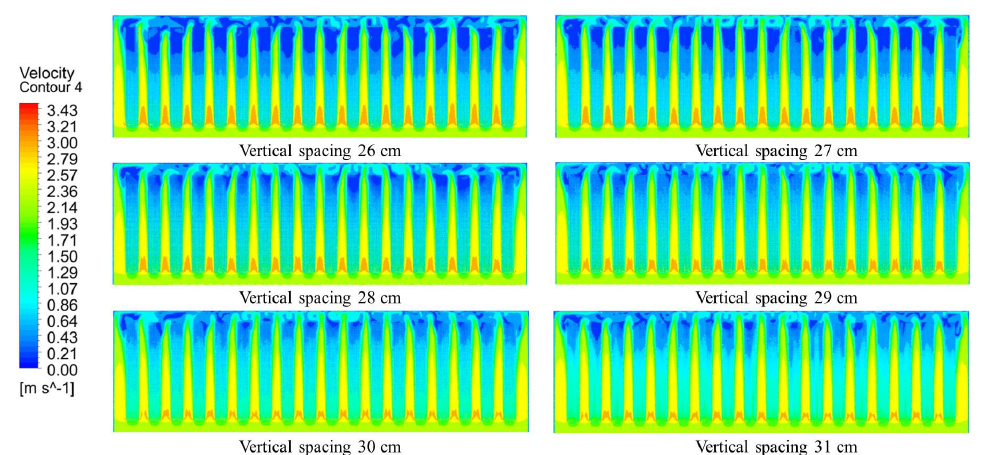
Figure 11. Velocity distributions of typical cross sections under different vertical spacings of culti- vation racks.